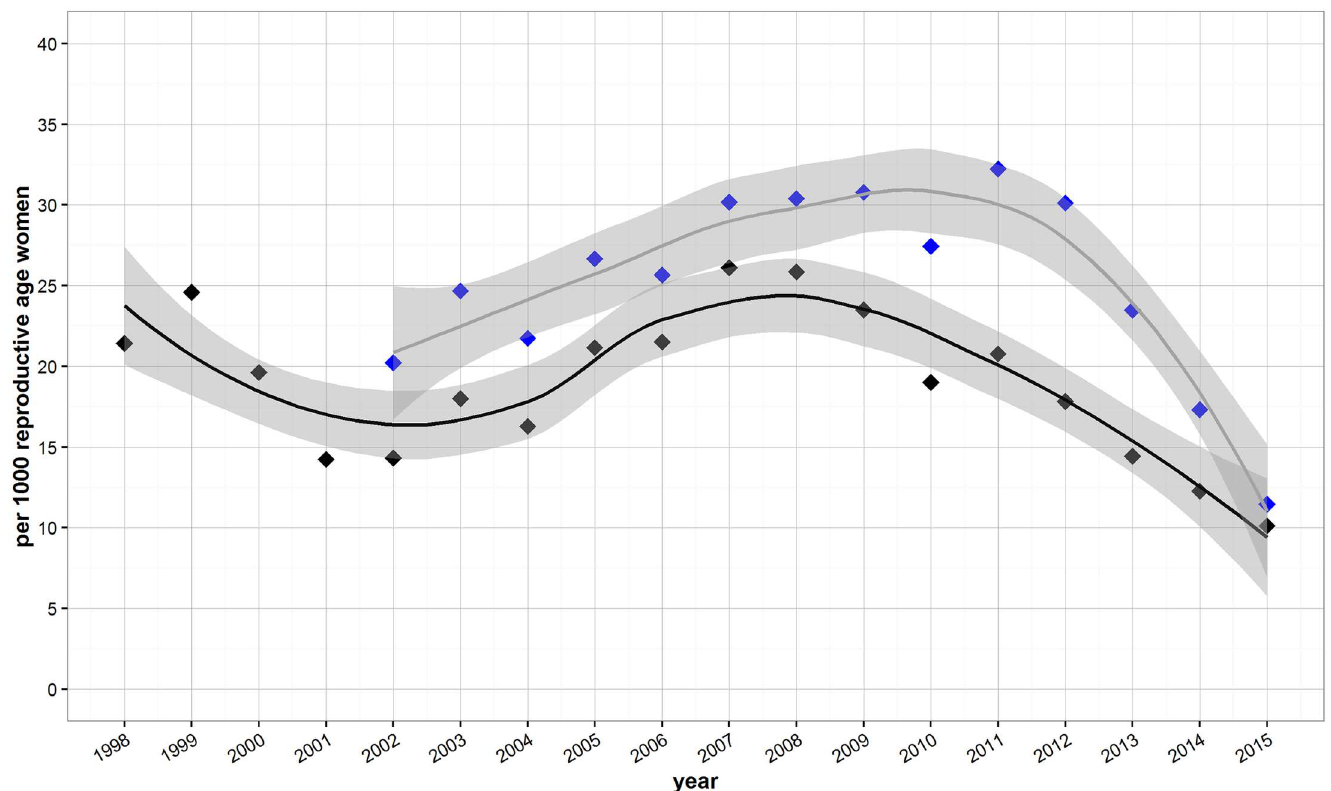
Fig 4. Miscarriages per 1,000 reproductive age women over time. Blue points are rates calculatedusing UNHCR population estimates and black points are from estimates using TBBC populationestimates. A loess curve (solid line) is fit to the data points and 95% confidenceintervals for the curve are shown in dark